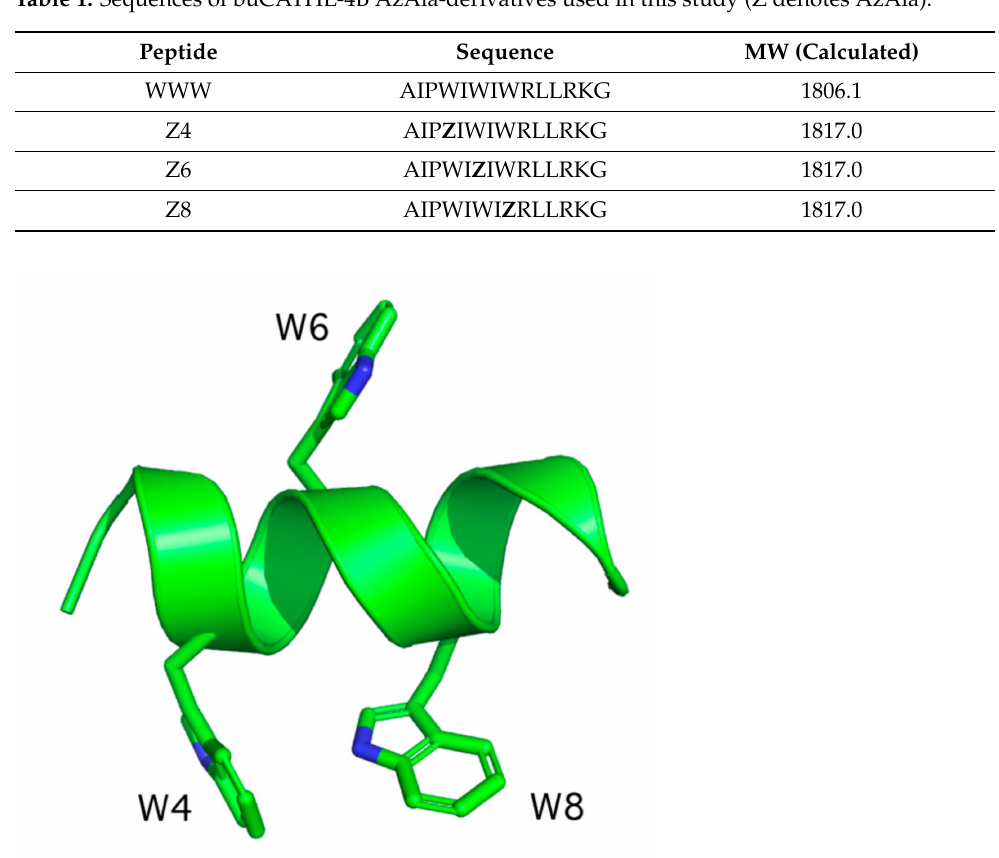
Figure 1. Peptide WWW with three tryptophan residues (W) marked as W4, W6, and W8. The model was generated using Phyre2 tool and then visualized in